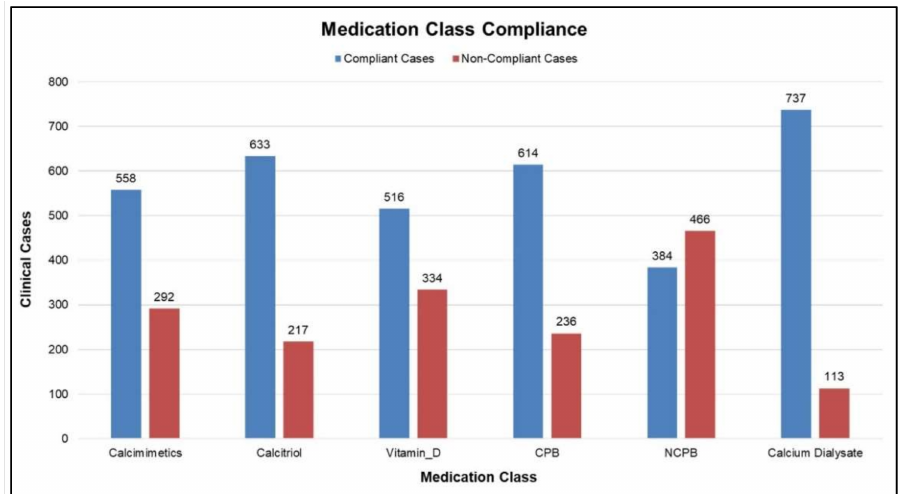
Figure 12. Compliance among different medication management classes along with dialysate calcium concentration.